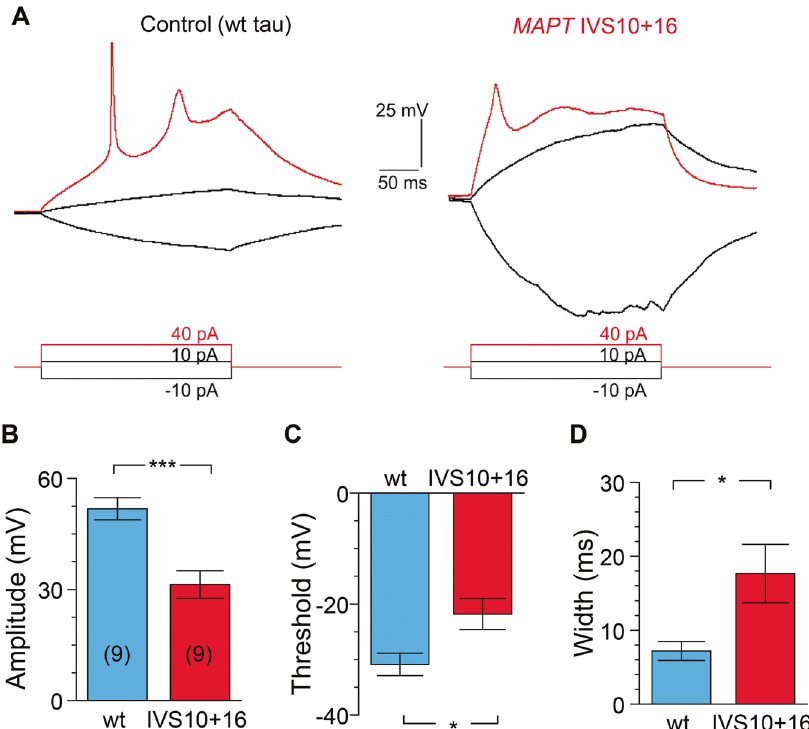
Fig. 5 MAPT IVS10 + 16 neurons display impaired action potentials. A Example recordings of action potentials (AP) in a control (wild type, wt, tau) iPSC-derived neuron (left) and a MAPT IVS10 + 16 neuron (right) elicited by square depolarizing current pulses (indicated on the bottom). B – D Statistics for the AP amplitude ( B ), the threshold ( C ) and the width measured at half-maximal amplitude in control (wt tau) and MAPT IVS10 + 16 neurons. Analysis performed for the fi rst AP spike. Data are mean ± s.e.m. *** P < 0.001, p = 0.031 for ( C ), and p = 0.039 for ( D ) (the two-tailed unpaired t -test). Number of cells, n = 9 per